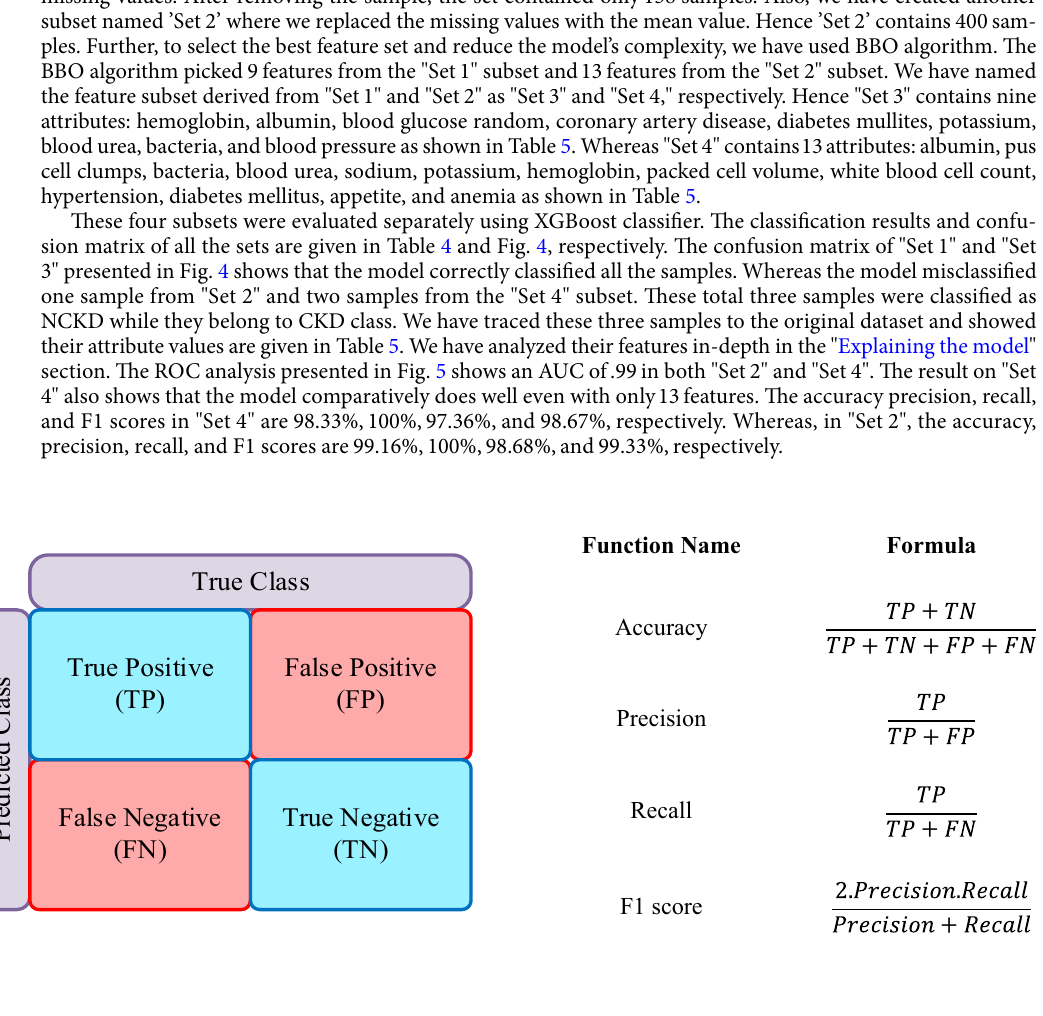
Figure 3. Confusion matrix and performance metrics